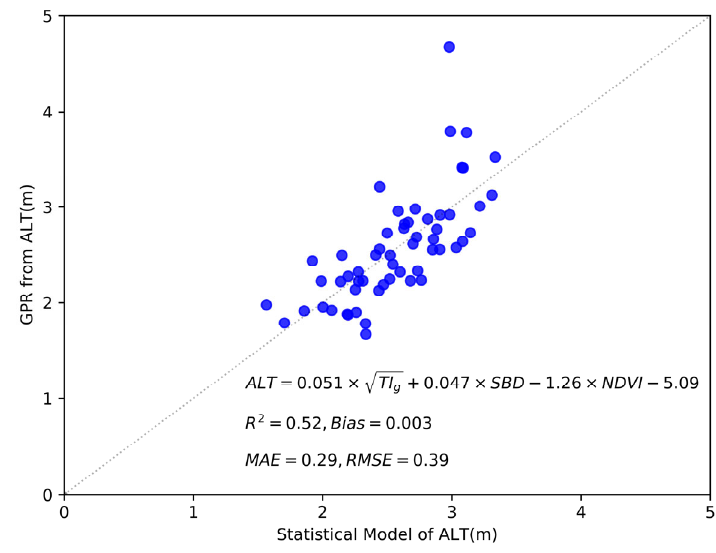
Figure 10. Active layer thickness (ALT) as a function of ground thawing index ( TI g ), soil bulk density (SBD), and normalized difference vegetation index (NDVI). Table 2. Multifactor statistical model parameters for ALT estimation. Factors Model Parameter